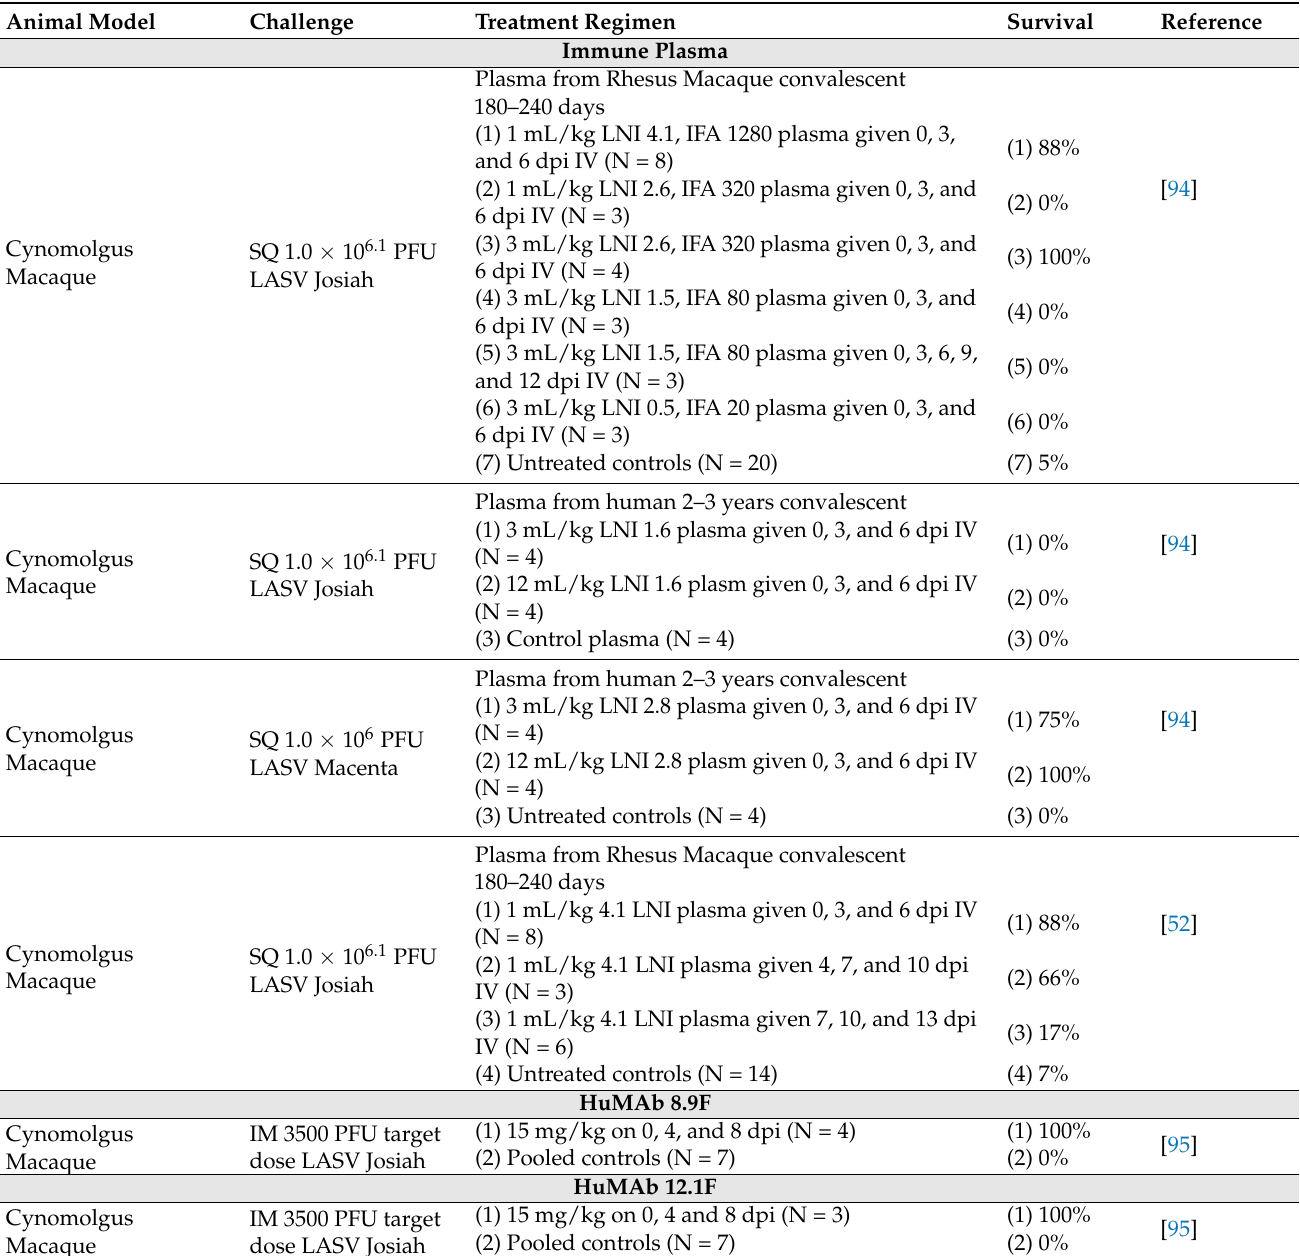
Table 2. Antibody based therapeutics for LASV in NHP